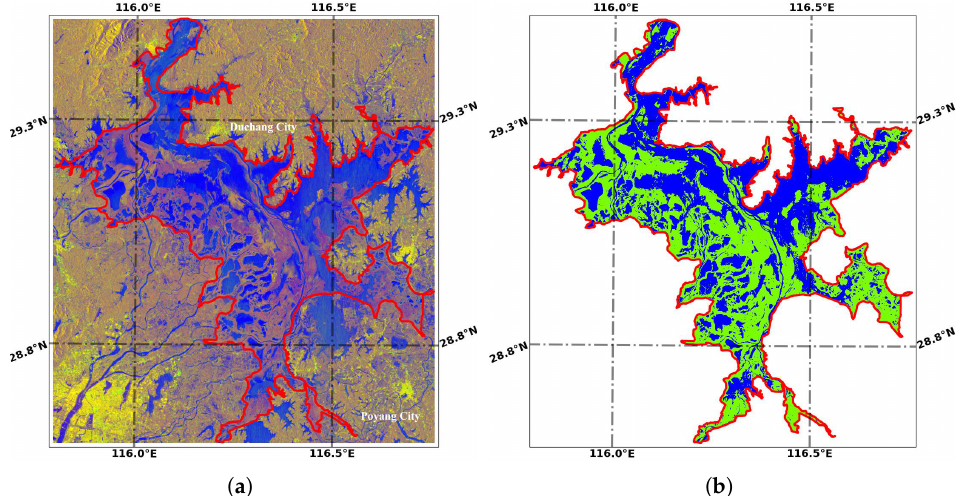
Figure 19. The influence of wind-induced waves on water extraction. ( a ) is for the Sentinel-1 SAR data acquired on 15 February 2020, and displayed in VH/VV/(VV + VH), and ( b ) is for the classification result, with blue used for water and green for non-water. ( a ) Sentinel-1 SAR data; ( b ) classification